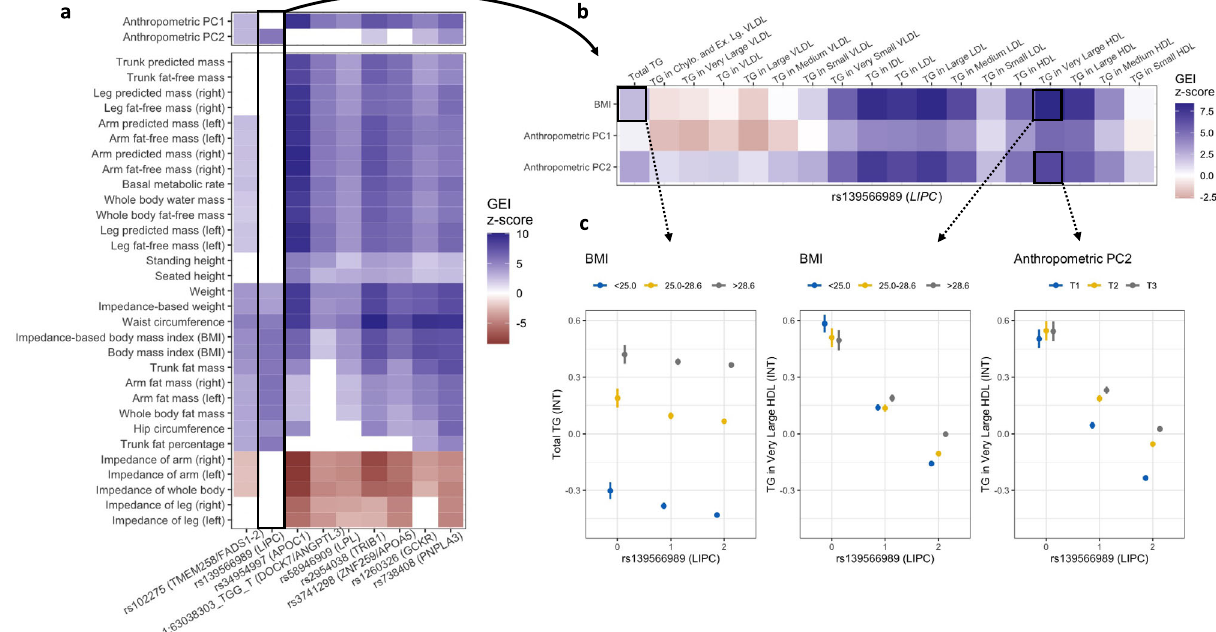
Fig. 4 Exploration of anthropometric interactions in fl uencing triglycerides. a Heatmap shows interaction z-scores from standard linear regression models between nine genetic variants ( x axis) and 33 anthropometric exposures ( y axis). Colored panels pass a nominal signi fi cance threshold ( p < 0.05). Variants are annotated with the closest gene, as well as a second likely causal gene based on manual annotation where appropriate. b Heatmap shows interaction z scores for a single variant (rs139566989 in LIPC ), with varying TG lipid subfraction outcomes from nuclear magnetic resonance ( x axis) and three representative anthropometric exposures ( y axis). c Three strati fi ed plots showing means and 95% con fi dence intervals for inverse-normal transformed total TG or TG in very large HDL after strati fi cation by rs139566989 and tertiles of the relevant exposure (labeled at the top of each plot; n = 90,644 total